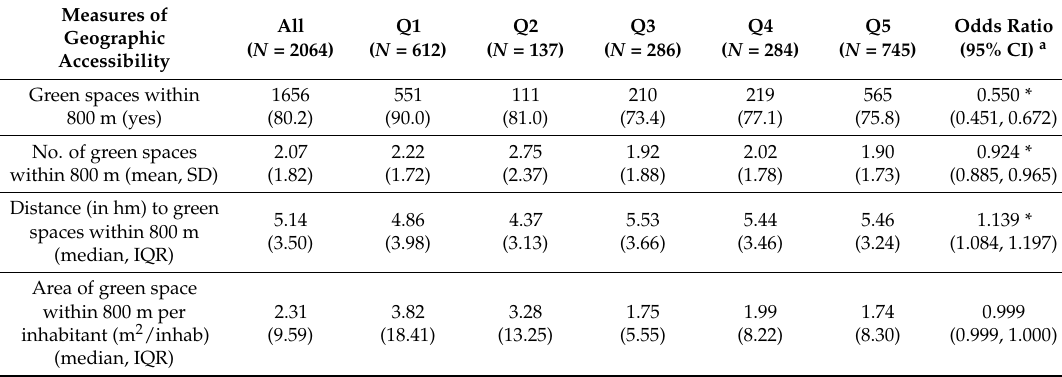
Table 1. Geographic accessibility to green space according to neighbourhood socioeconomic deprivation quintiles.